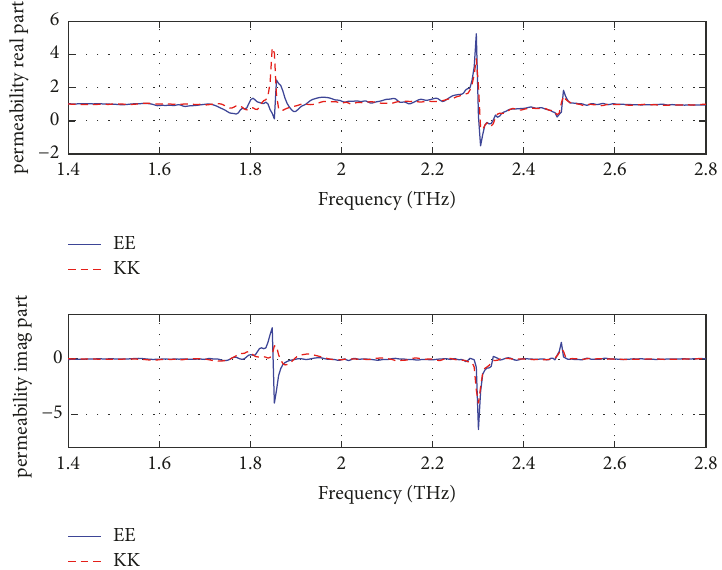
Figure 17: The comparison between the extracted permeability and Kramers-Kronig